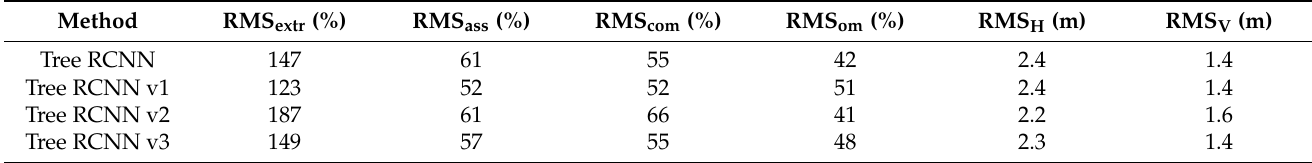
Table 5. Detection performance of Tree RCNN with a different structure for all plots.